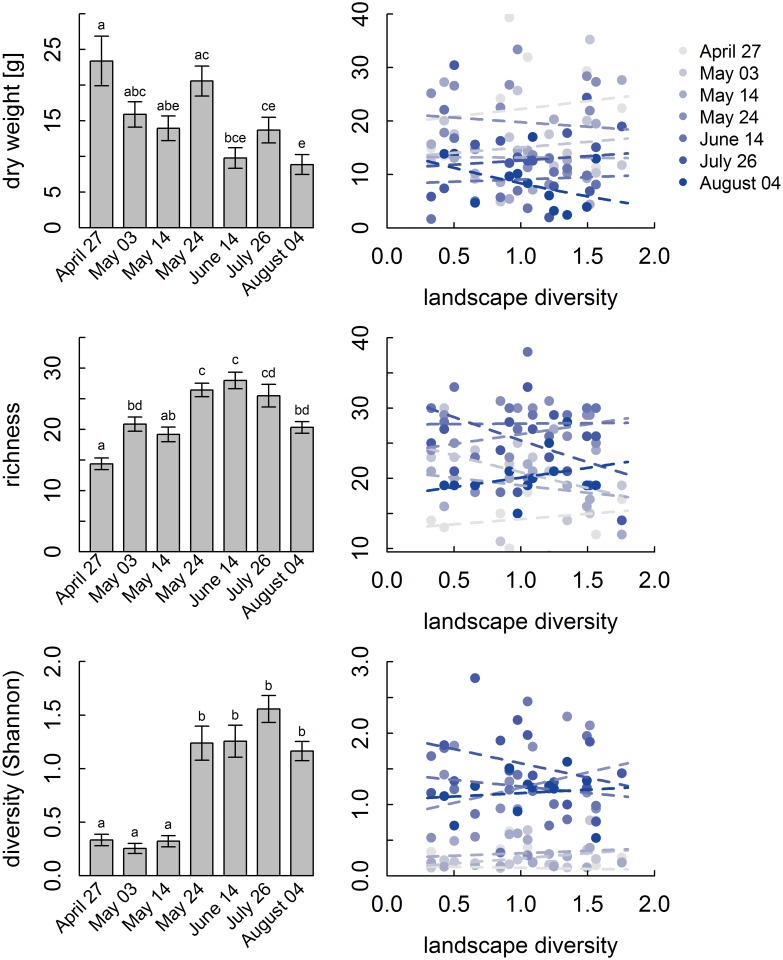
Dry weight, richness and diversity of pollen samples.Different letters above bars indicate significant differences (P < 0.05). The respective relationships to landscape diversity in interaction with date are shown on the right and are not significant. Pollen was collected by honey bee colonies on seven dates in 16 landscapes.